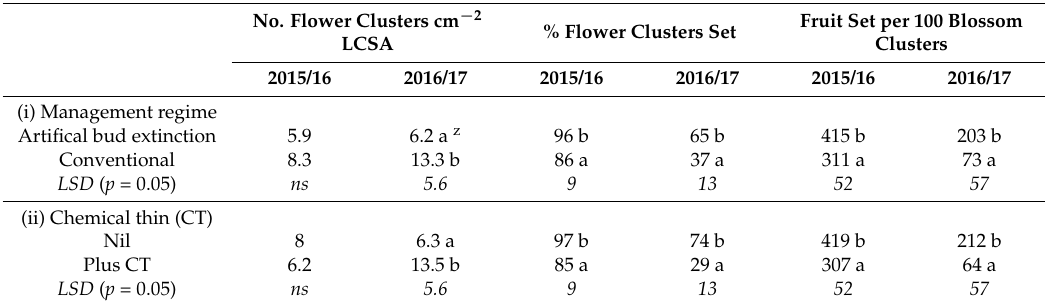
Table 4. Effect of management regime and thinning method on fruit set and final crop load of ‘Fiero Fuji’ (Trial 3). LCSA = limb cross-sectional